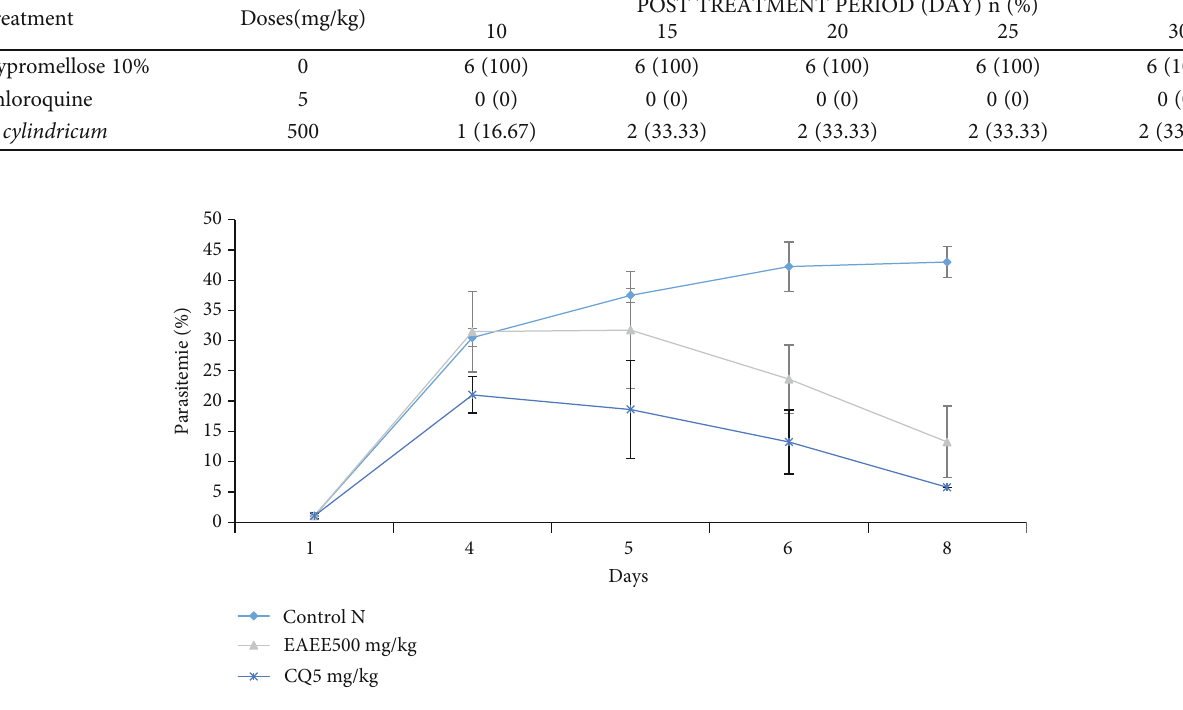
Figure 2: Curative e ff ect of E. cylindricum crude extract. Phytochemical screening